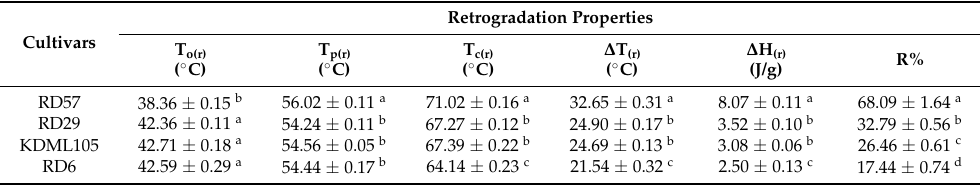
Table 5. Retrogradation properties of starches from four Thai commercial rice cultivars with different starch pasting properties.